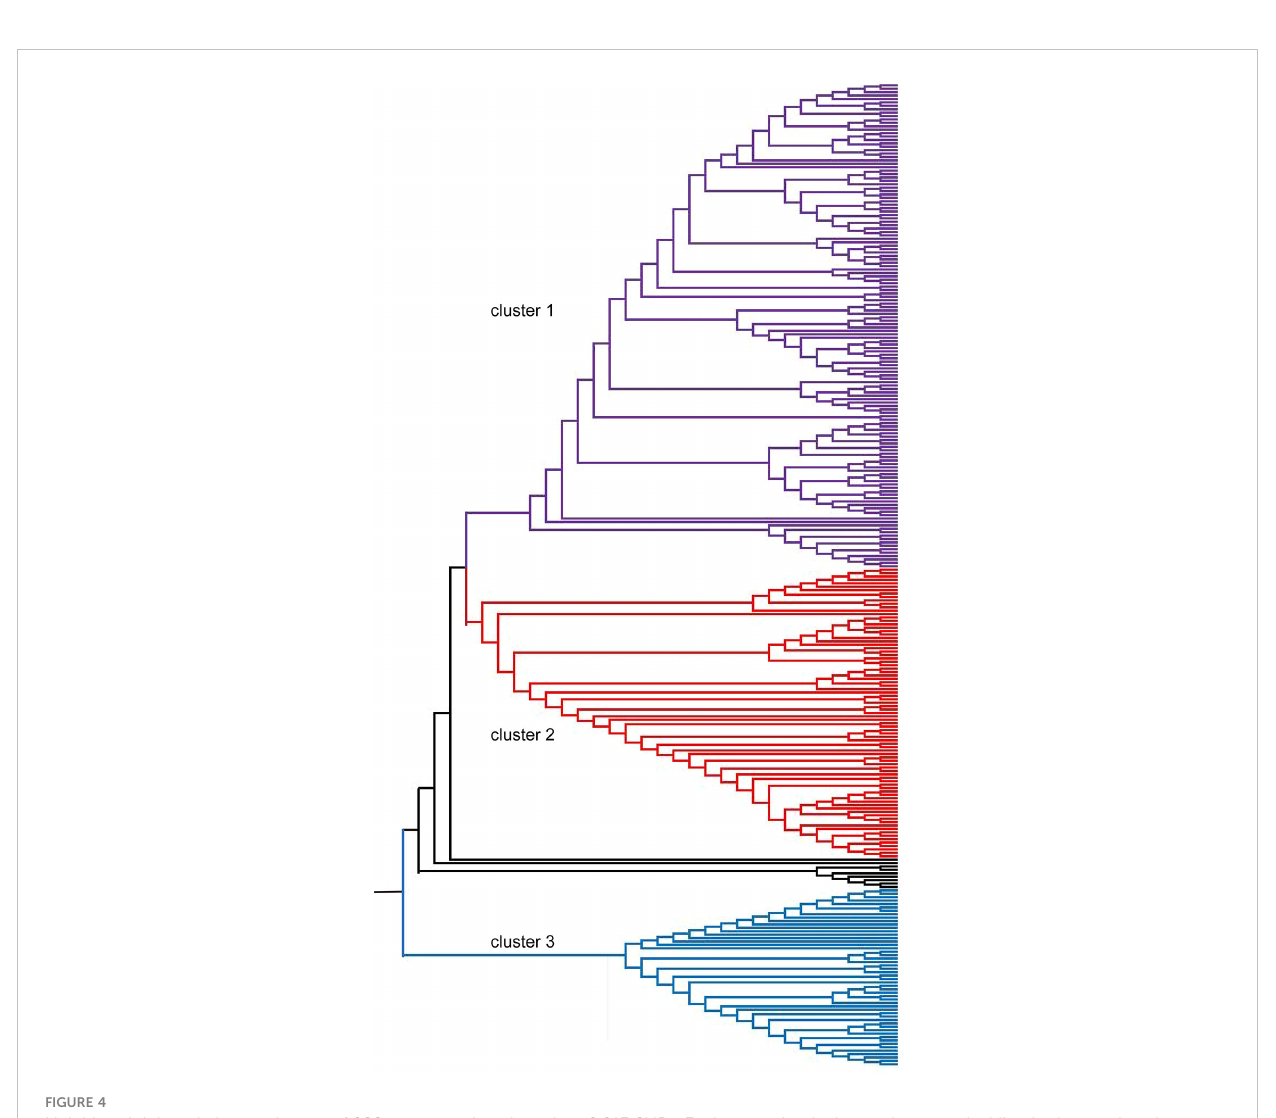
FIGURE 4 Neighbor-joining phylogenetic tree of 288 oat accessions based on 2,213 SNPs. Each accession is denoted as a vertical line in three colored subclades corresponding to the three